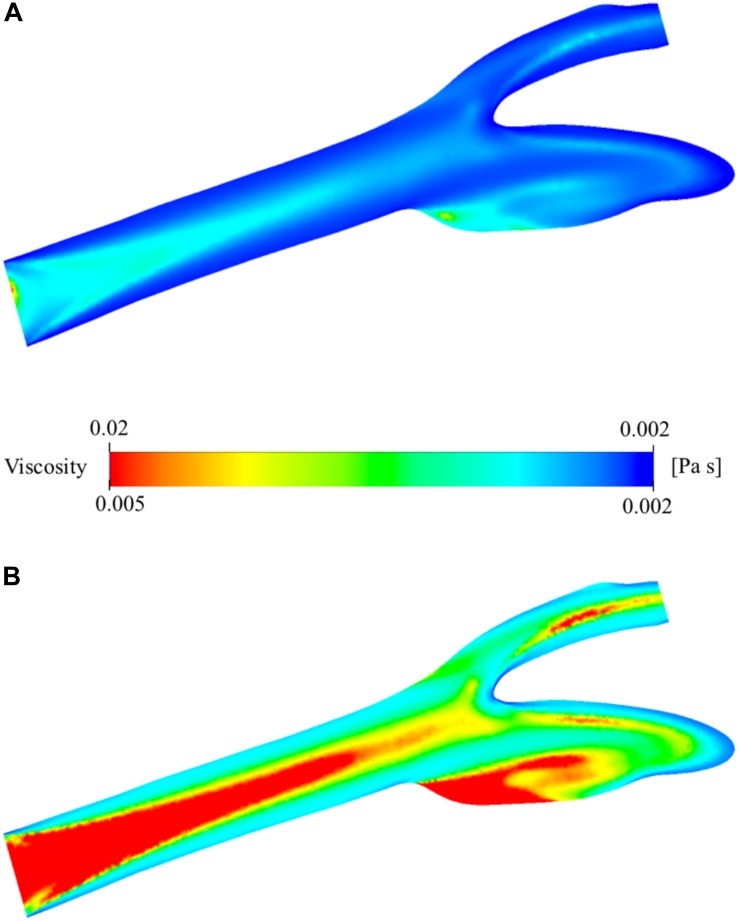
Viscosity distribution on the two-dimensional midplane in the axial direction. (A) shows the range with minimum and maximum viscosity values while (B) shows the scaled-down range of the viscosity for detailed visualization.